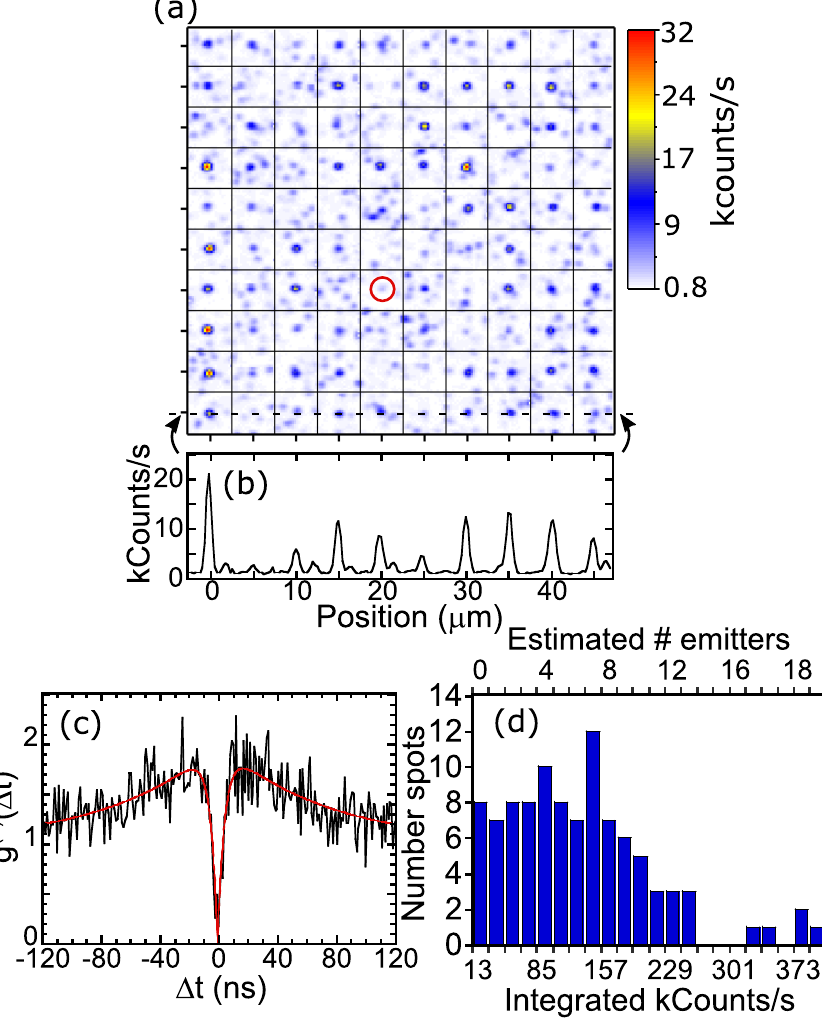
Figure 3. ( a ) Room temperature confocal fluorescence map of a 10 ions/spot pattern after further cleaning and 400 °C anneal. Tick marks represent 5 µm. ( b ) Line cut of integrated emission counts vs. position. ( c ) 2 ) (� t ) Background-corrected second-order autocorrelation function g ( at room temperature from the spot circled in ( a ). ( d ) Histogram of emission counts for the 50 spots in the implantation pattern in ( a